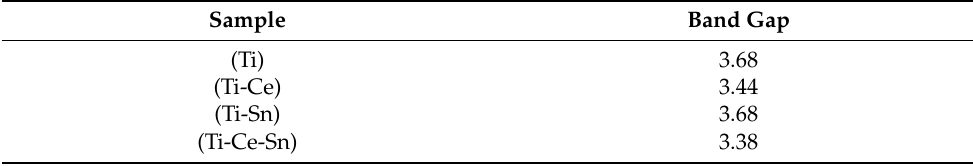
Figure 5. Absorbance data ( a ) and Tauc plot ( b ) for prepared films. Table 2. Band gaps determined from UV–Vis